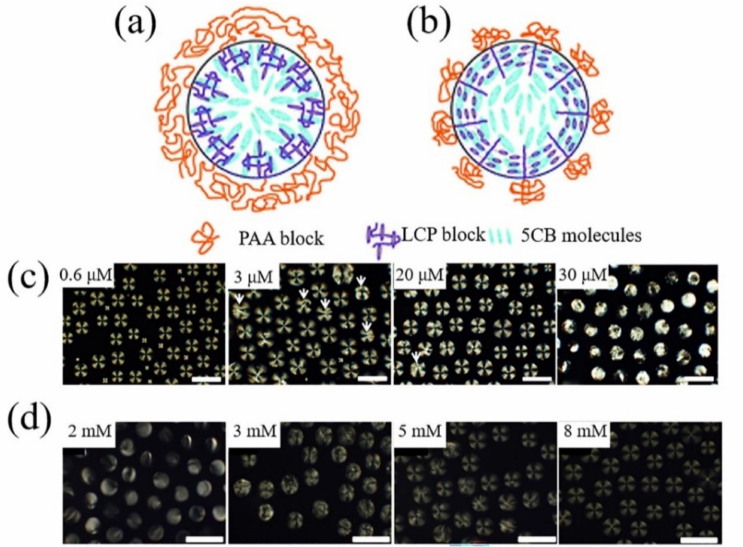
Figure 6. Configurations of PAA-b-LCP-decorated LC droplet at ( a ) higher pH and ( b )